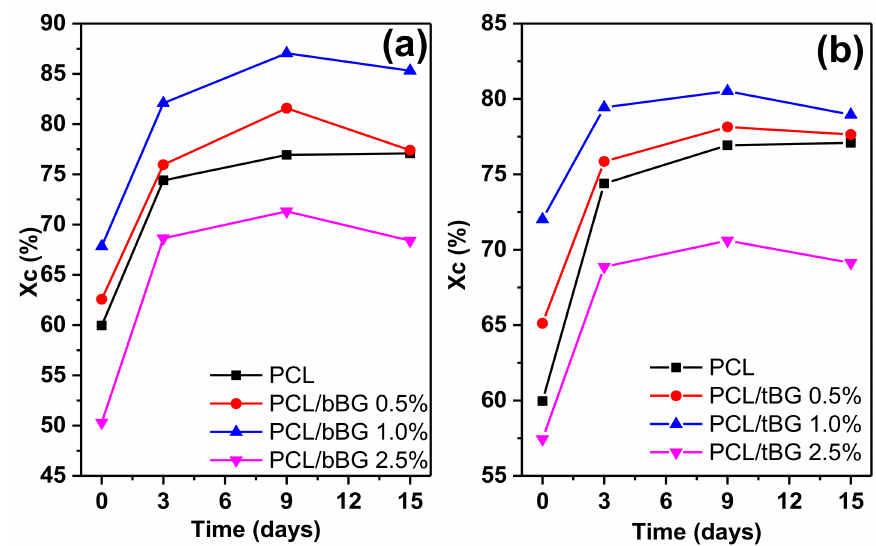
Figure A3. Changes in the crystallinity of ( a ) PCL/bBG and ( b ) PCL/tBG nanocomposites during enzymatic degradation (calculated by DSC, heating with rate 10 ◦